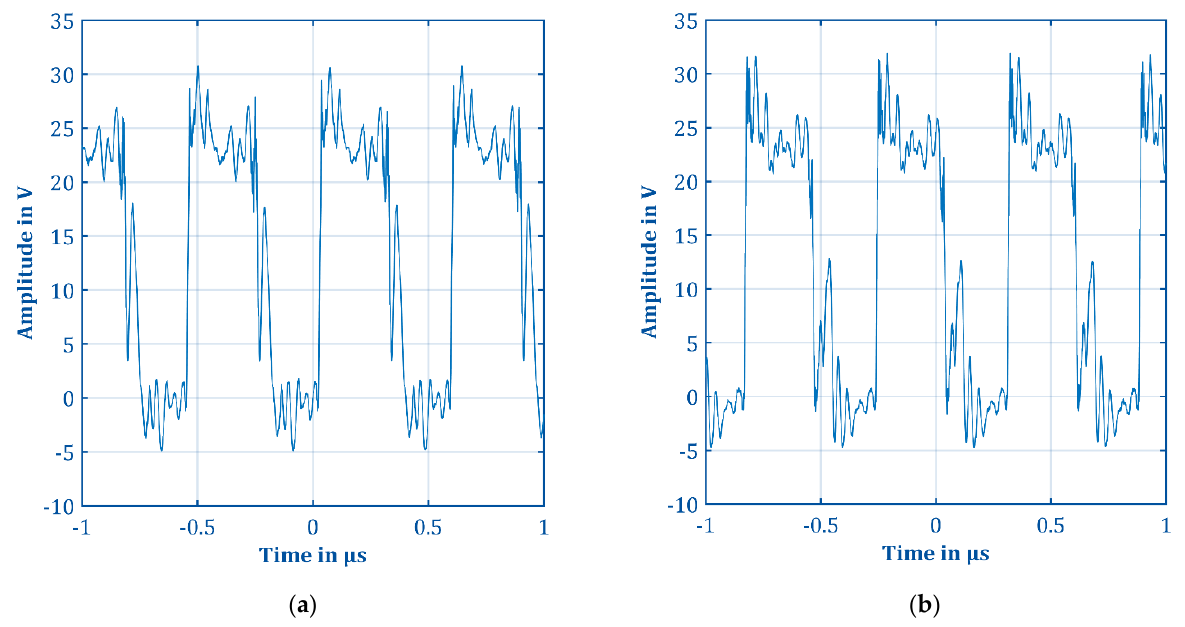
Figure A6. ( a ) Left input of the improved voltage rectification and regulation electronic, see Figure 5, in blue after the transformer with the coupling capacitor referenced to ground, at 1.75 MHz with the Square PCB transformer; all other transformers look almost identical. ( b ) Shows the other input at the same time, also referenced to ground. Figure A7a,b show the voltage signals at the primary winding of the transformers at 1.75 MHz.